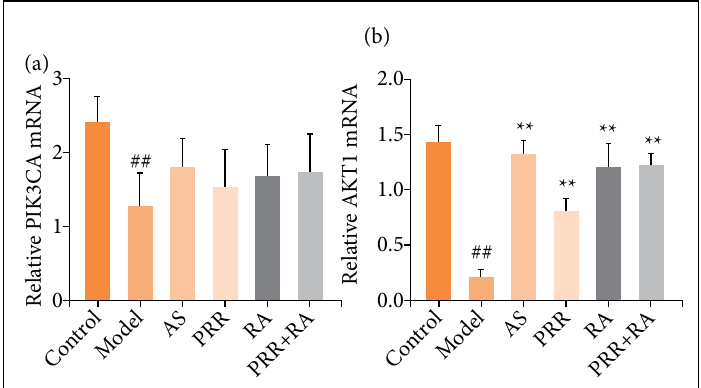
Figure 4 - Comparison of PIK3CA and Akt1 expression in bone tissue of rats in each group #